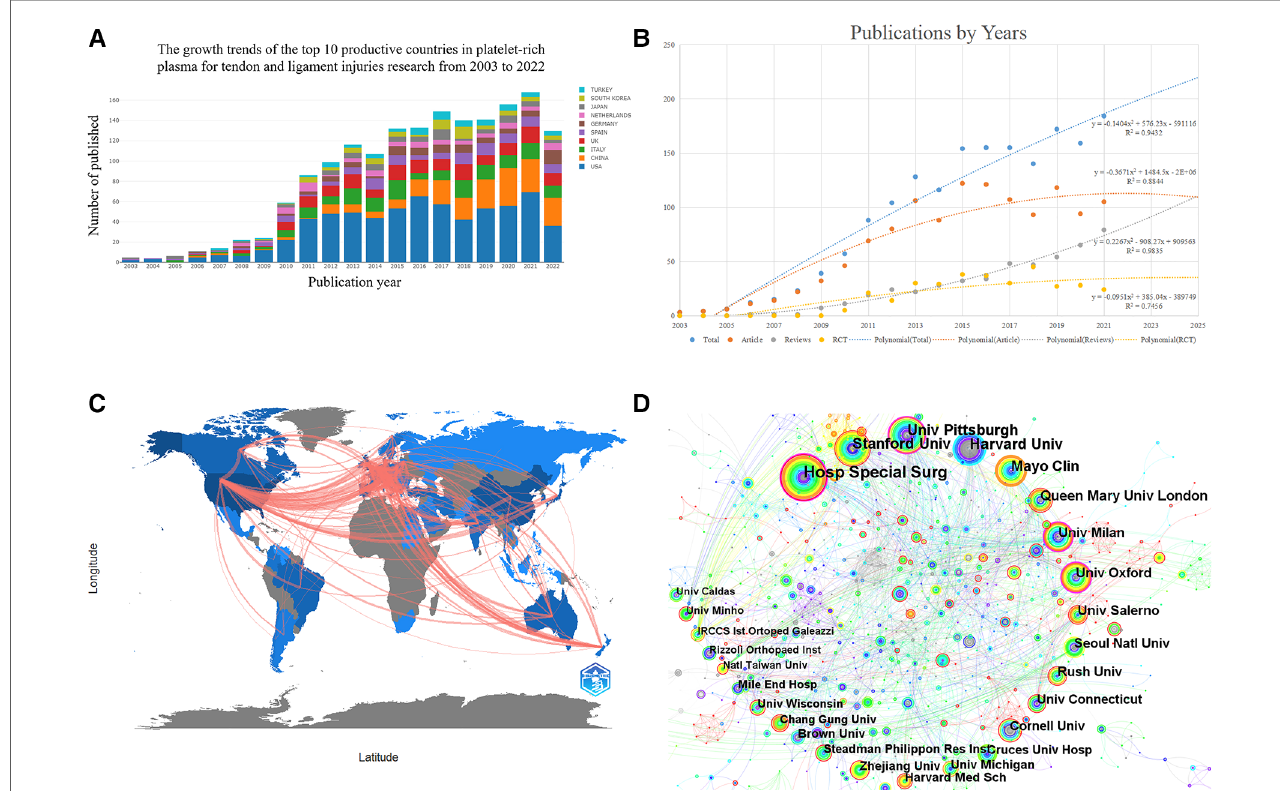
FIGURE 2 ( A ) bibliometric analysis of the WoS core database output. The number of publications on platelet-rich plasma studies for tendon and ligament injuries published in different countries has changed year by year from 2003 to 2022. ( B ) Publication trends in the fi eld of platelet-rich plasma for tendon and ligament injury research and corresponding polynomial fi t curves. ( C ) Collaborative bibliometric analysis of countries in the fi eld of platelet-rich plasma for tendon and ligament injury research, with darker colors representing more publications and connecting lines representing collaborative relationships. ( D ) Institutional co-occurrence network diagram of using platelet-rich plasma to treat ligament and tendon injuries. Note: The circle in the chart indicates the volume of articles issued. The larger the circle indicates the more articles issued by the institution, the thickness of the purple outer circle represents the centrality of the institution, and the connecting line represents the existence of cooperation or co-occurrence.